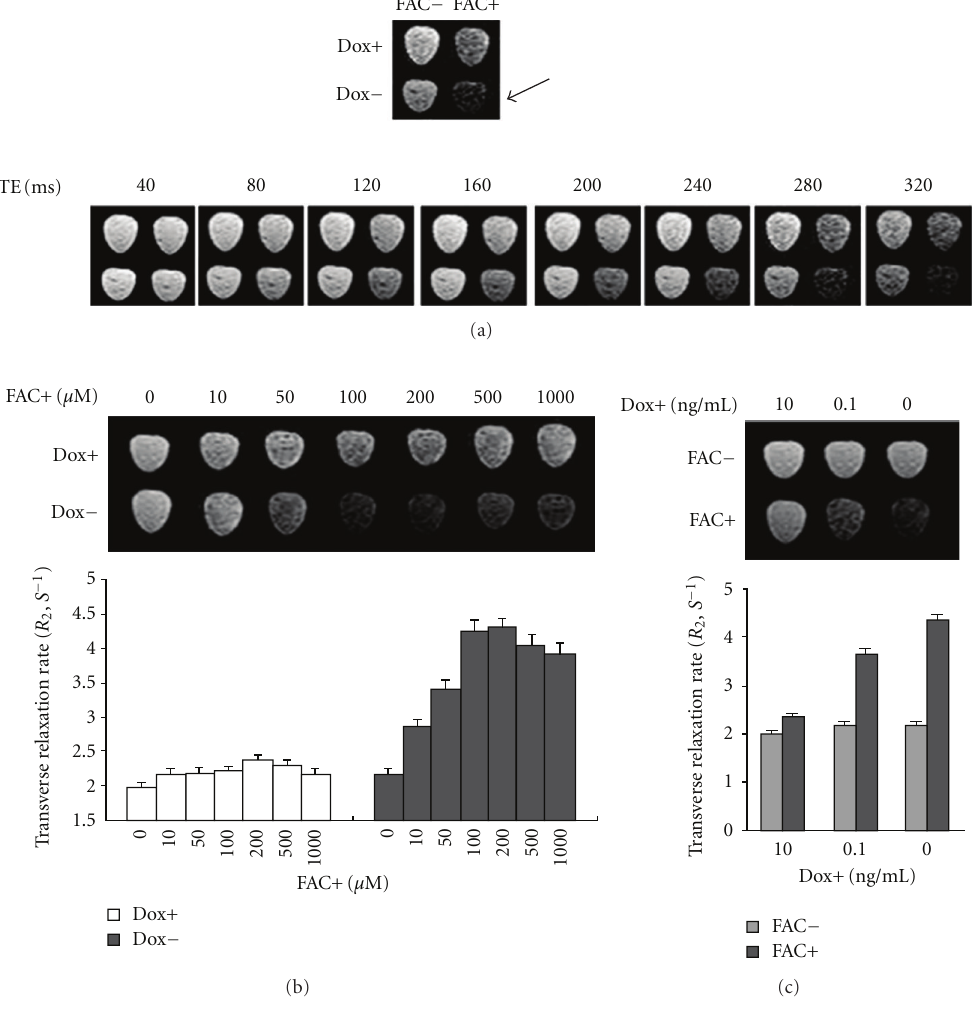
Figure 5: B-7 cells under both derepressed state (FTH1 overexpression) and the presence of FAC supplementation was capable of producing visible contrast by MRI. (a) B-7 cells were cultured with or without 10ng/mL doxycycline and with or without FAC for T 2 -weighted images. Arrow indicated the sample with the highest R 2 , in the presence of both FTH1 overexpression and iron supplementation (200 μ M) for 48 h. (b) B-7 cells were grown for 48h in the presence of FAC at di ff erent concentrations. (c) B-7 cells grown in doxycycline (Dox) at di ff erent concentrations for 96 h, and in 200 μ M FAC for 48 h before analysis. Relaxation rates derived from the R 2 maps were expressed as mean ± SD for 3